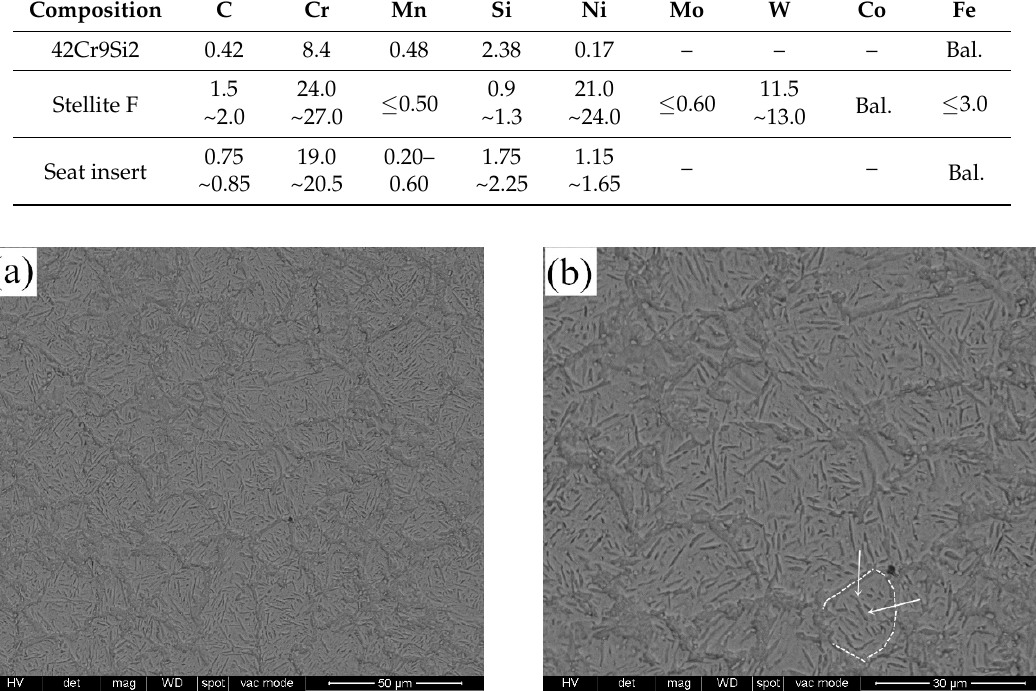
Table 2. Chemical composition of the 42Cr9Si2 steel and Stellite F and seat insert (wt.%). Bal.: Balance. Table 3. Mechanical properties of the 42Cr9Si2 steel.